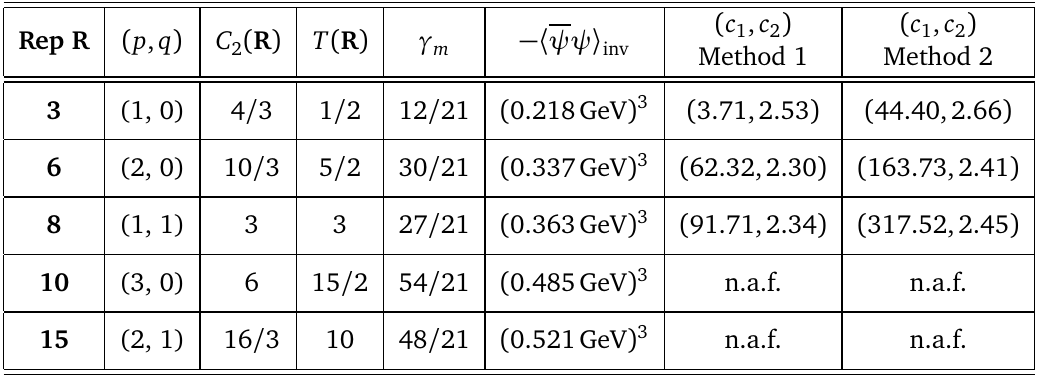
Figure 5: Perturbative one-loop running coupling α (blue line) and for the case of SM + a single additional 1TeV vector-like fermion in a higher dimensional representation of SU ( 3 )